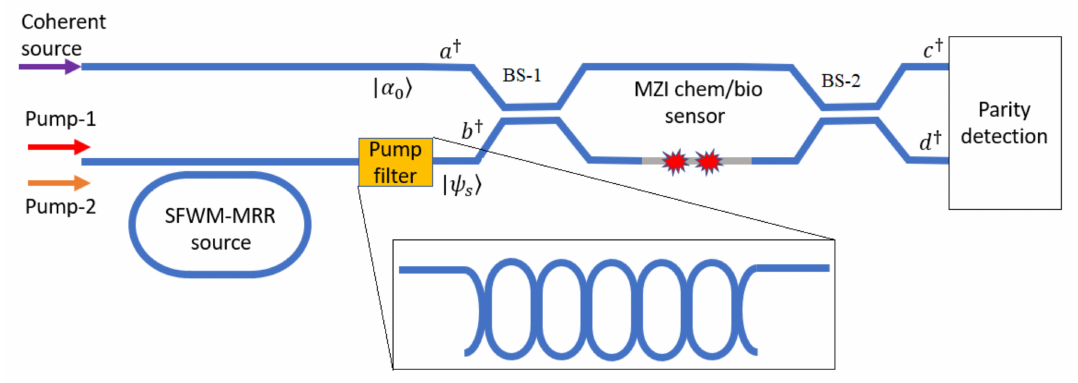
Figure 1. Chem / Bio sensor architecture based on the mixing between squeezed and coherent states. Inset: pump